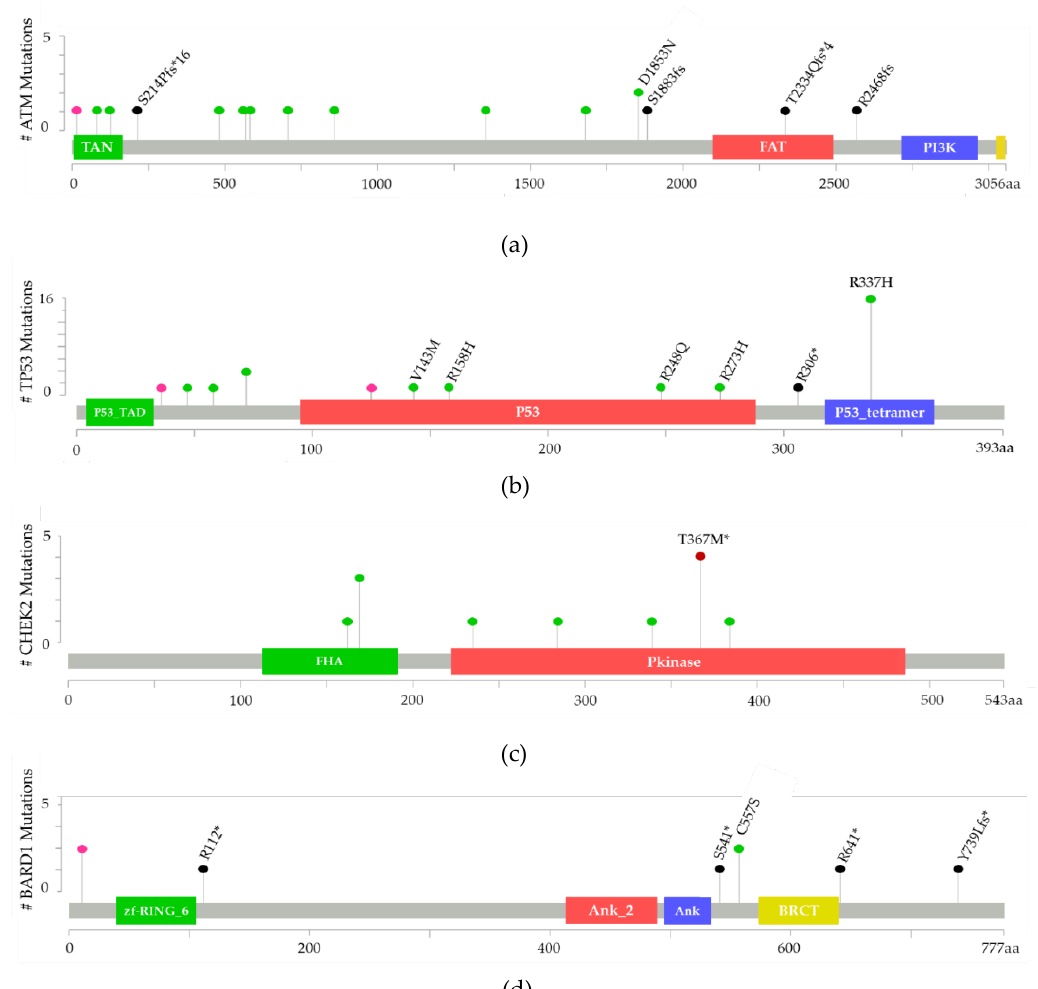
Figure 2. Mutations in non-BRCA genes reported in LA breast cancer patients. Frequently reported mutations are observed in ATM , TP53 , CHEK2 and BARD1 genes. (a) ATM likely loss of function and therefore likely oncogenic mutations S214Pfs*16, S1883fs, T2334Qfs*4, and R2568fs; (b) TP53 likely loss of function and therefore likely oncogenic mutations V143M, R158H, R248Q, R273H, R306*, and R337H; (c) CHEK2 most reported mutation T367M*; (d) BARD1 likely loss of function and therefore likely oncogenic mutations R112*, S541*, RG41* and Y739Lfs*. Mutation type: missense (green), truncating (black), in frame (red), other